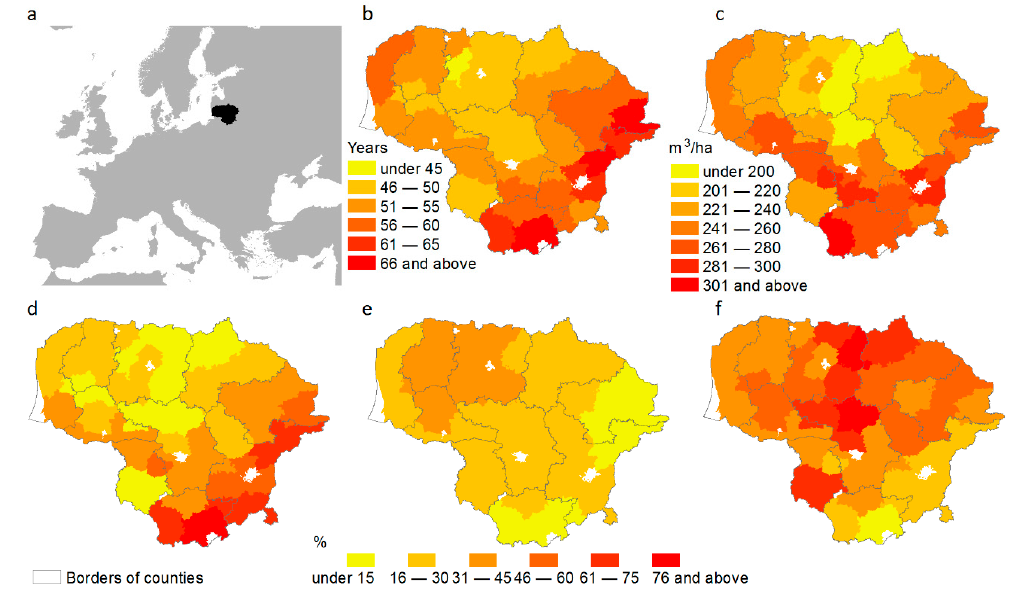
Figure 1. Basic characteristics of the study area to date: ( a ) Location of Lithuania in Europe, ( b ) average age of all forest stands, ( c ) average standing volume in 1 ha, ( d ) volume proportion of Scots pine, ( e ) volume proportion of Norway spruce, and ( f ) volume proportion of deciduous trees (produced based on data from forest state cadaster [50]).